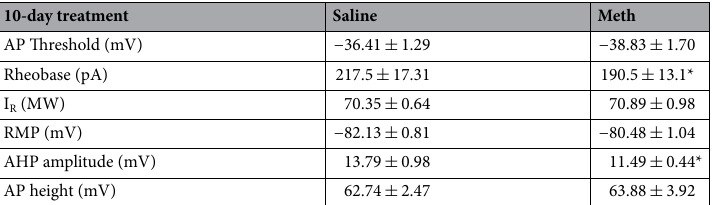
Table 1. DMS iSPN membrane properties: 1 day of abstinence. Data presented as mean ± s.e.m. and analyzed using unpaired t - or Mann–Whitney tests where appropriate; saline n = 16 neurons/6 mice; meth n = 19 neurons/7 mice; *p < 0.05.